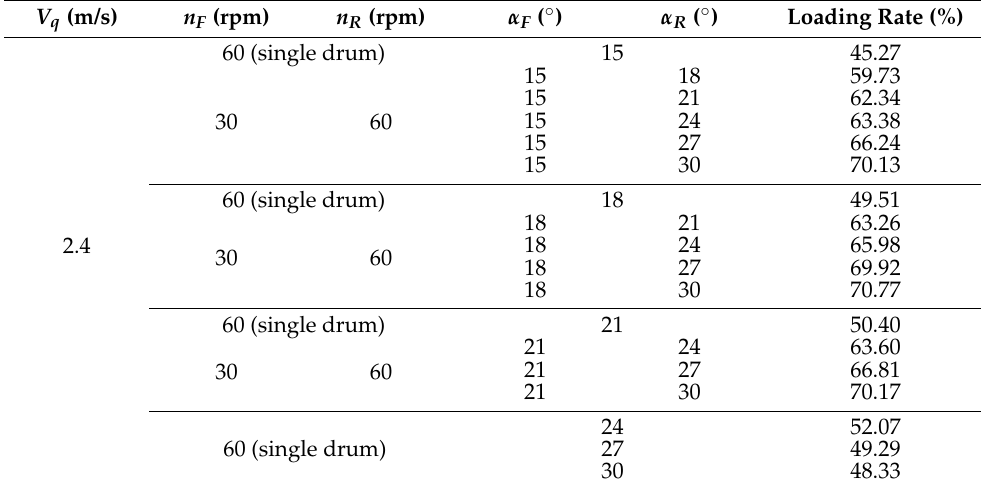
Table 6. The statistical results of loading rate under different helix angle